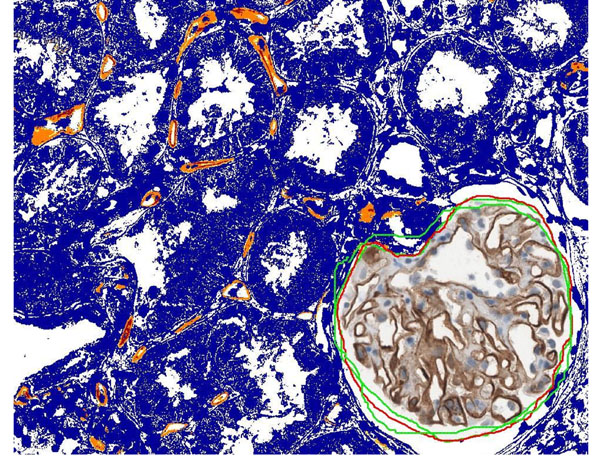
Automated image analysis in non-glomerular area. Glomeruli were excluded from this annotation layer. C4d positive peritubular capillaries are marked with orange (2+ intensity pixels) or red (3+ intensity pixels) colors.